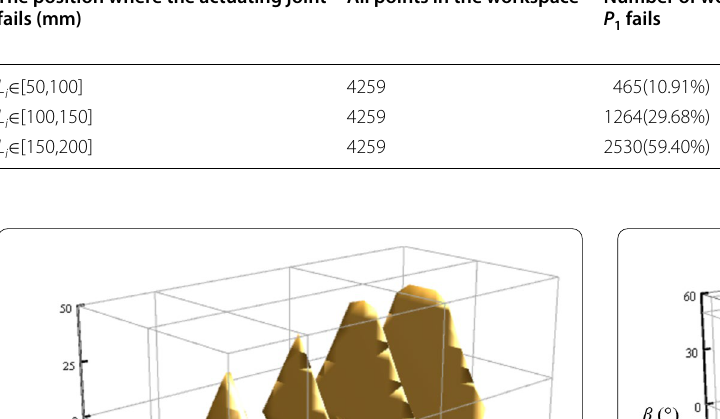
All points in the workspace Number of workspace points when P